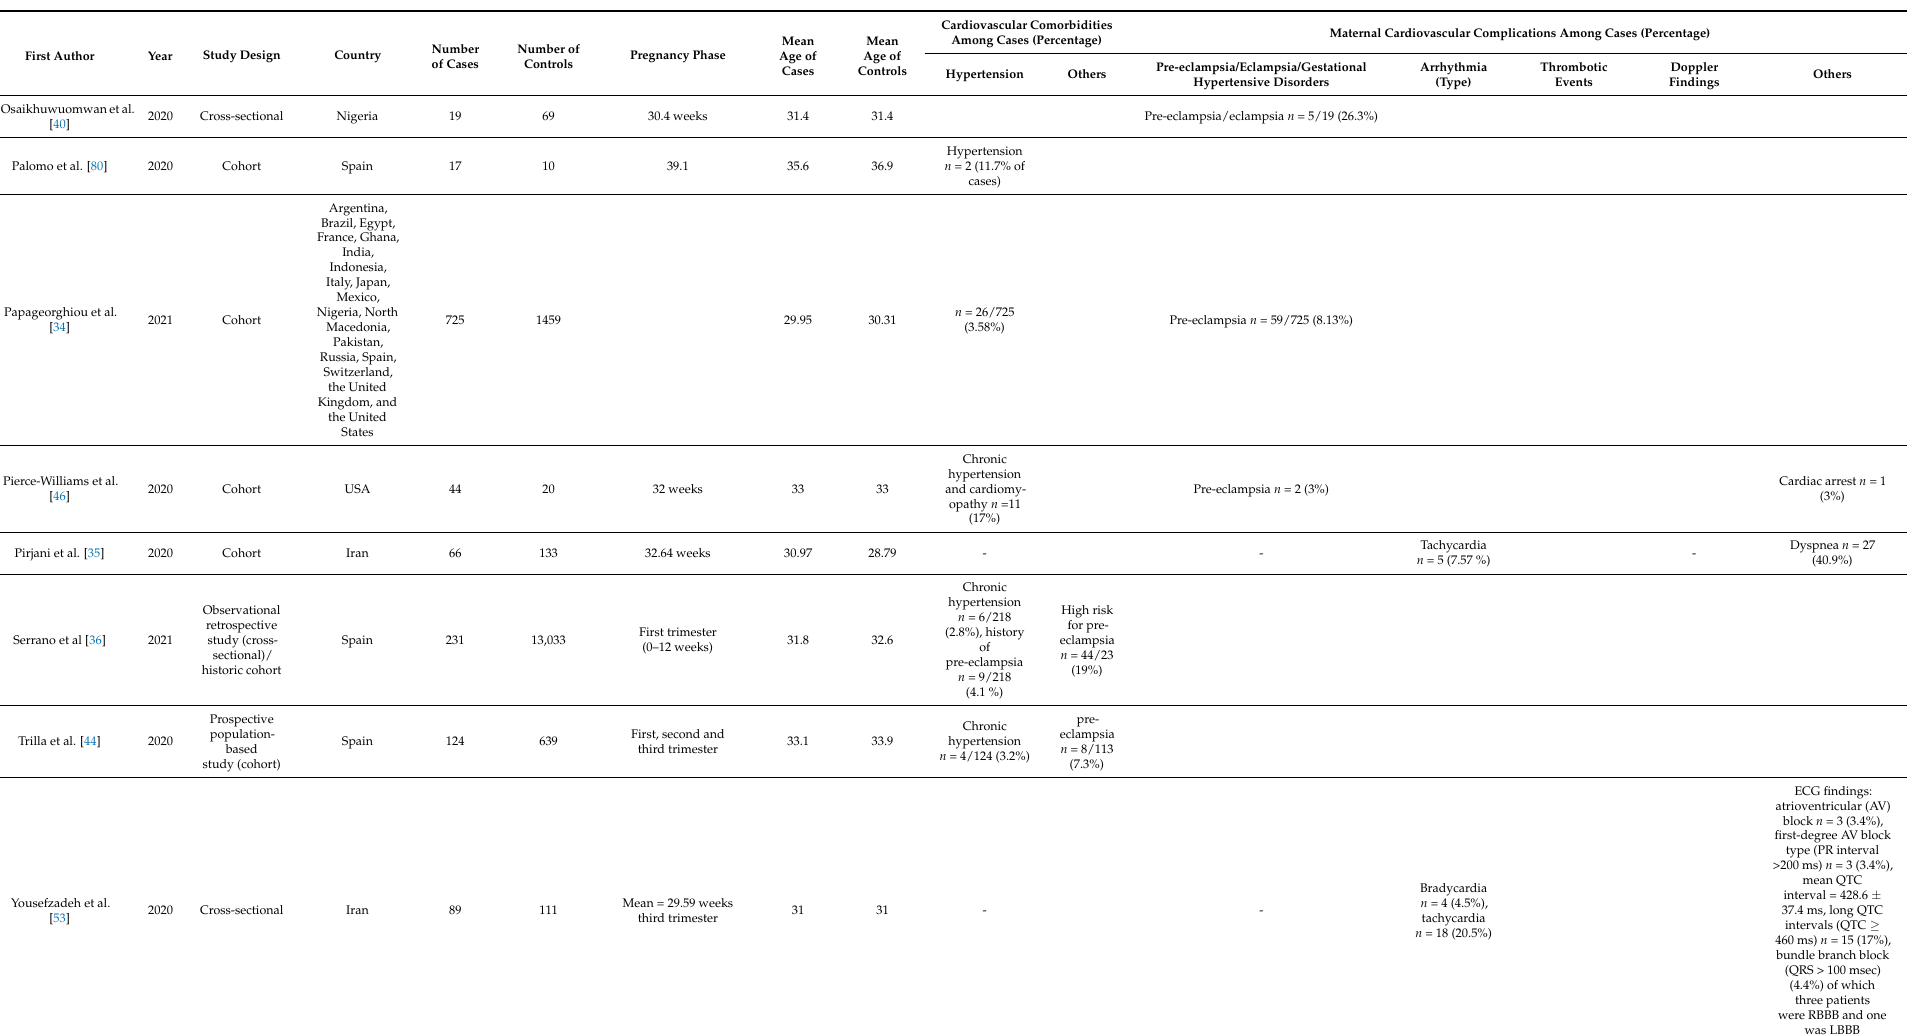
Bradycardia n =4(4.5%), tachycardia n =18(20.5%)